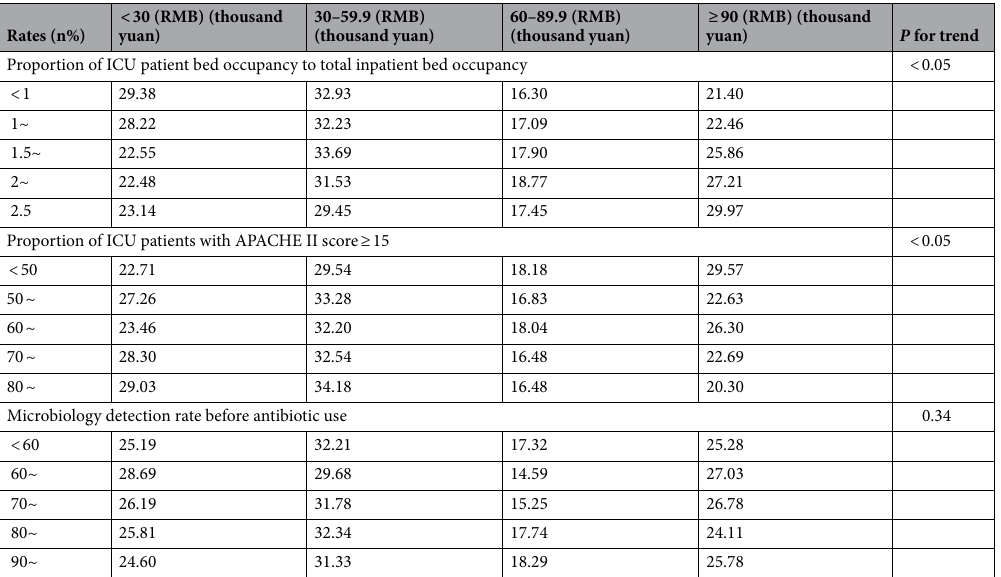
Table 3. Relationship between quality control indicators and costs. ICU, intensive care unit; APACHE, acute physiology and chronic health evaluation.